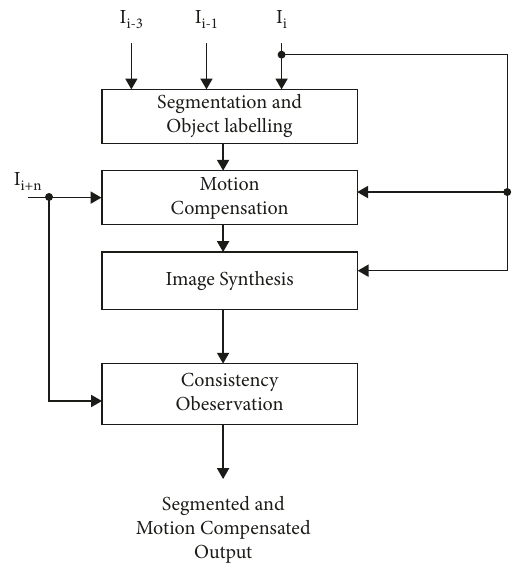
Figure 1: An algorithm for processing and analyzing